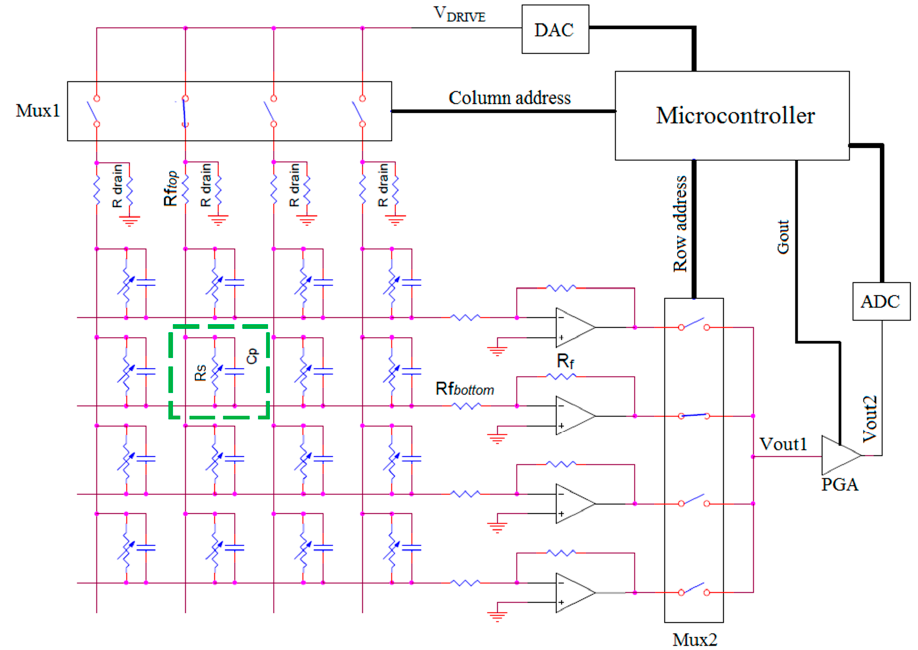
Figure 2. Simplified scheme of the data acquisition electronics.